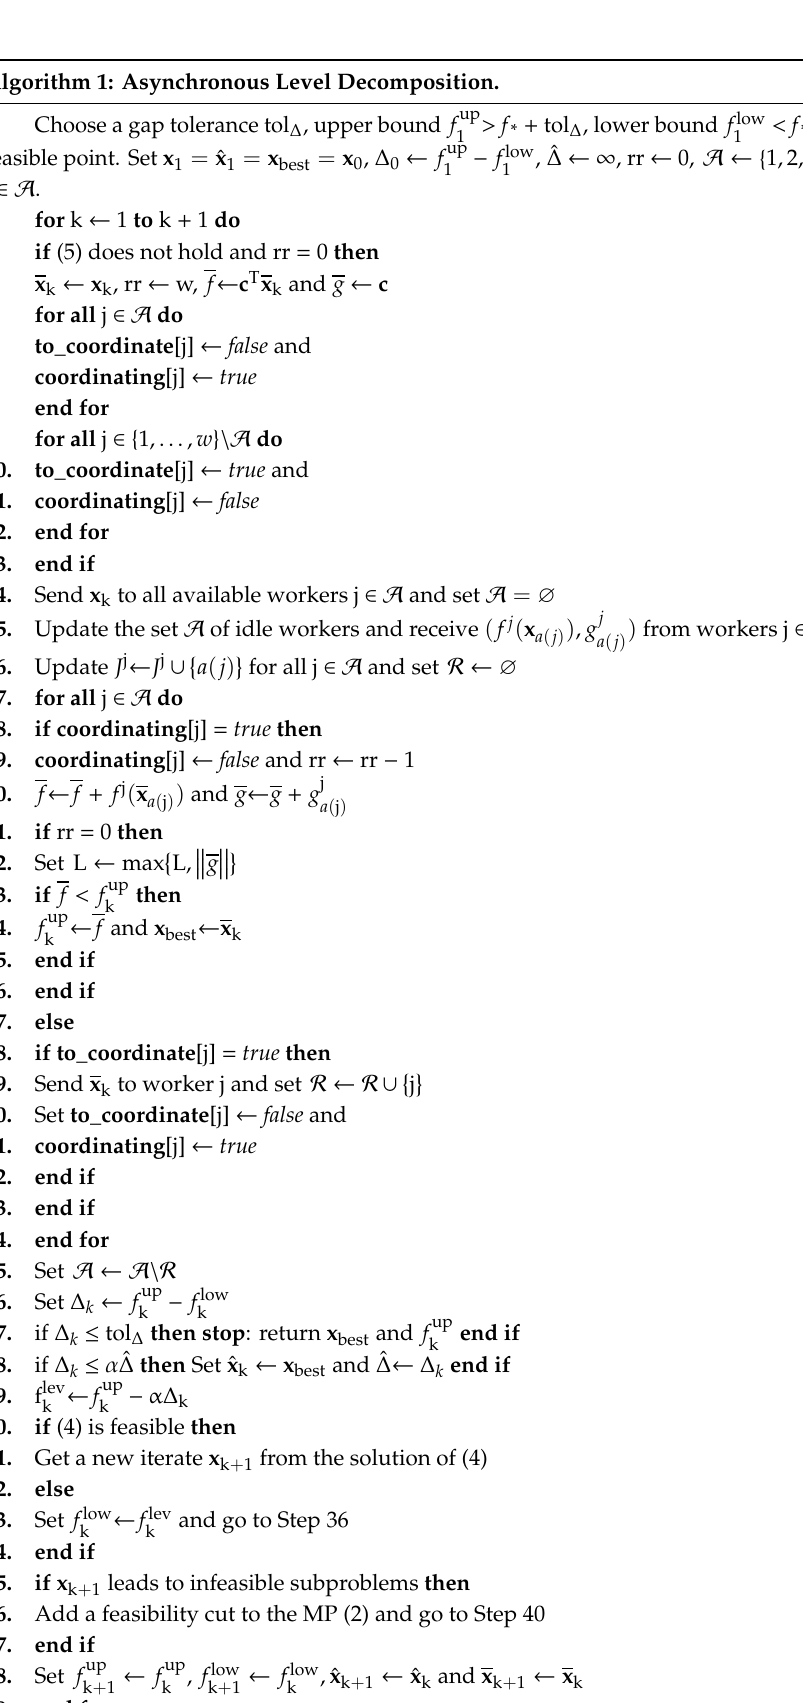
Algorithm 1: Asynchronous Level